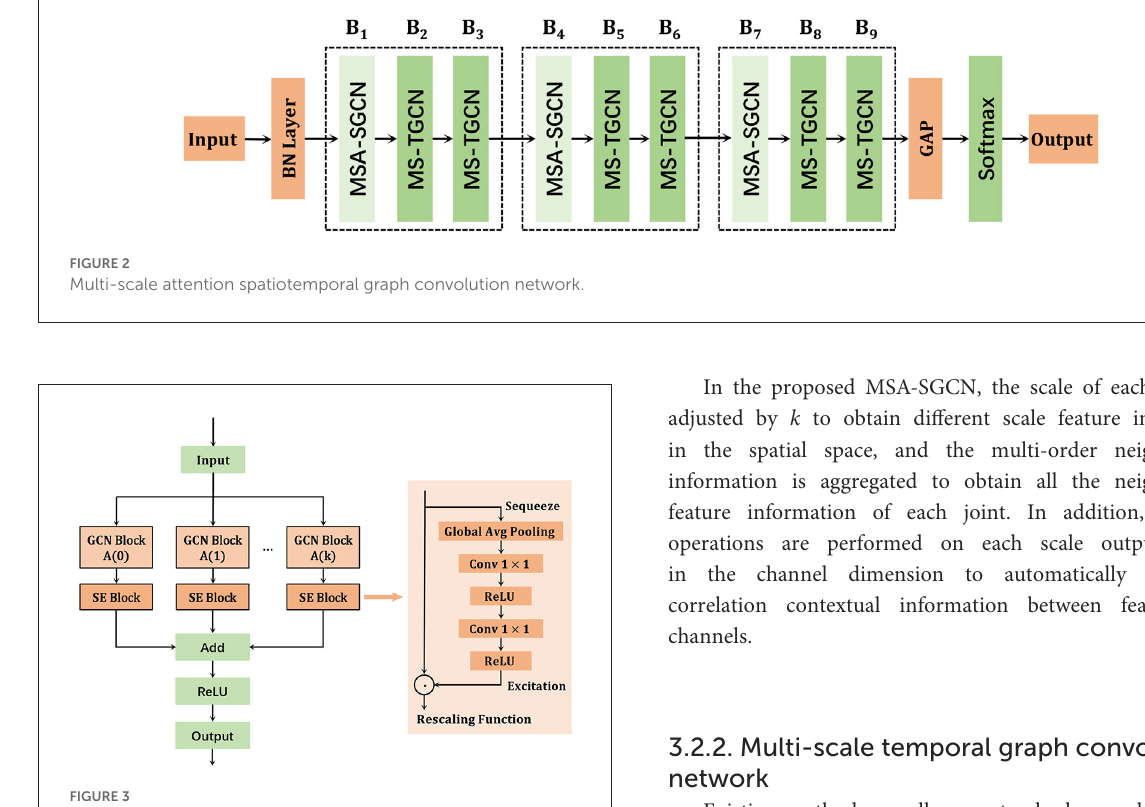
FIGURE3 Multi-scale attention enhanced spatial graph convolution